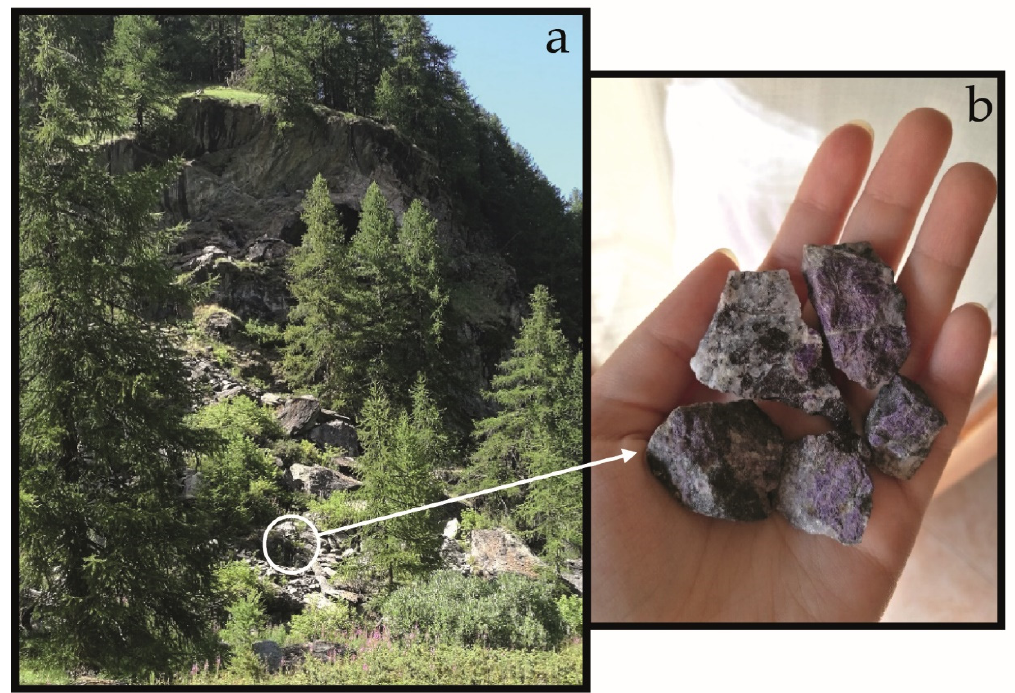
Figure 1. Mine and landfill of Prabona ( a ) and collected samples ( b ).